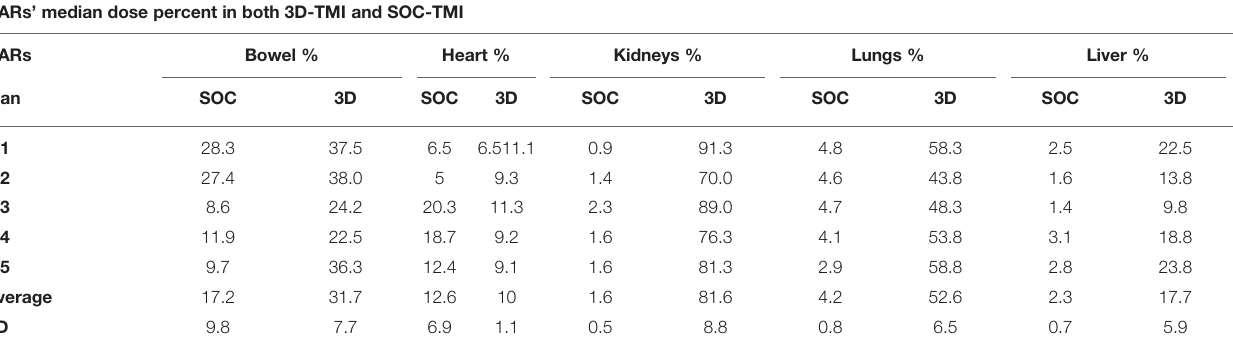
TABLE 1 | The median dose with standard deviation of the organs at risks for the 3D-TMI preclinical model versus the SOC-TMI preclinical model. OARs ’ median dose percent in both 3D-TMI and SOC-TMI OARs